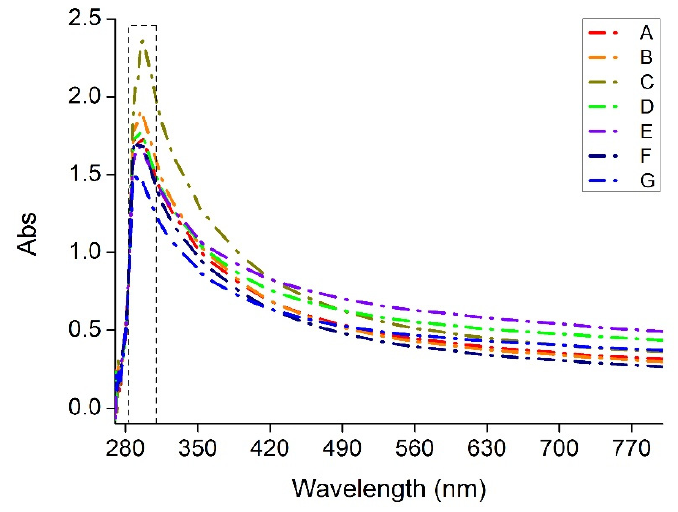
Figure 8. Absorbance of the heat pressed films ( A – G ) from wavelength 200 nm to 800 nm.